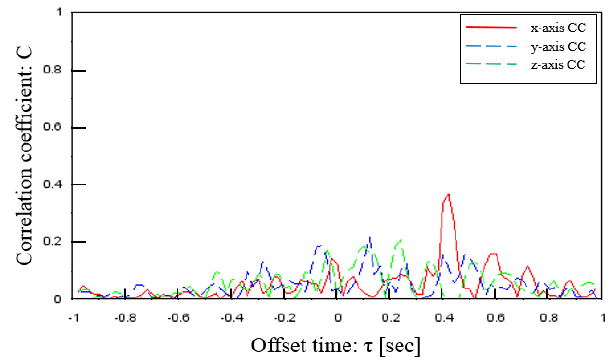
Figure 7: Correlation between true signal and signals from smartphone on the